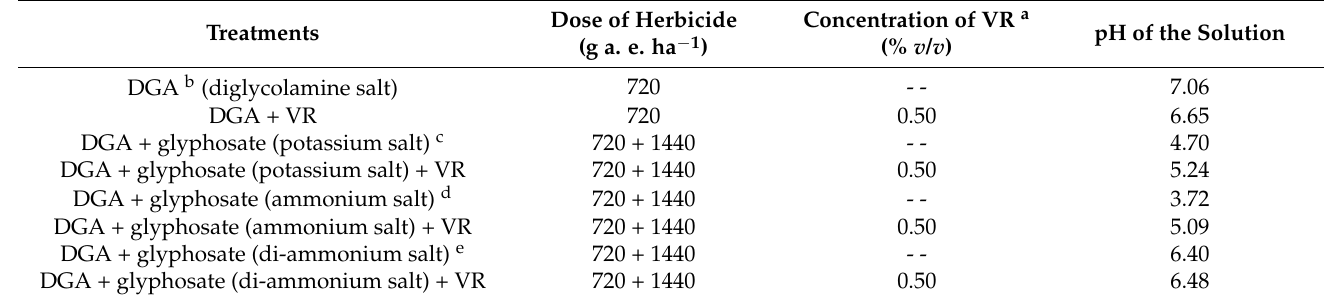
Table 2. Different treatments applied to corn